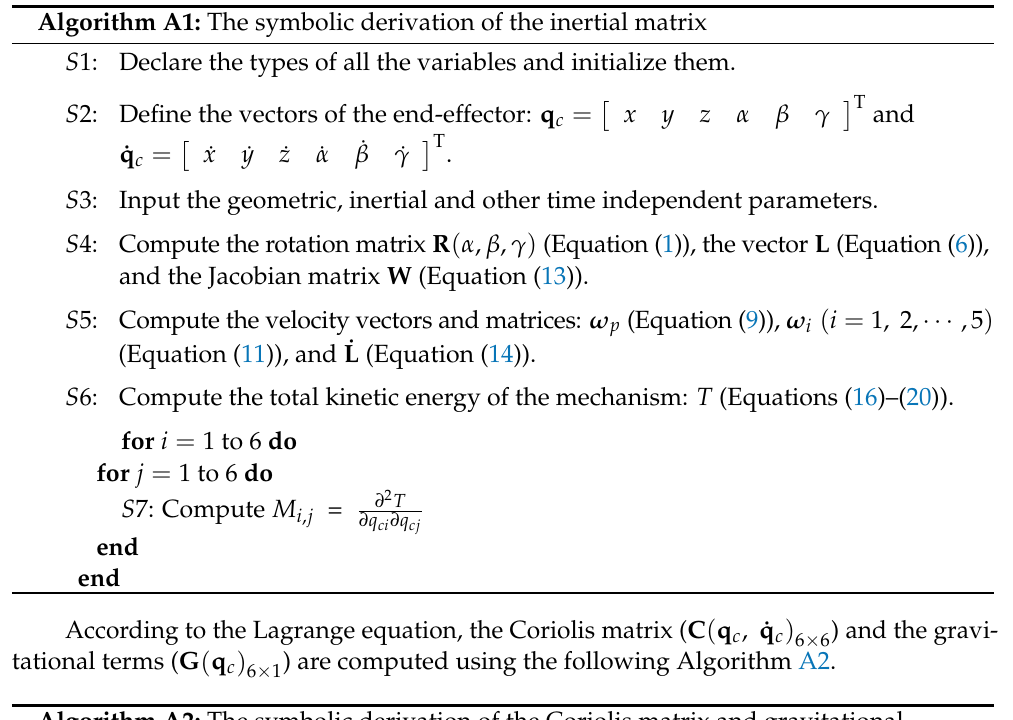
Algorithm A2: The symbolic derivation of the Coriolis matrix and